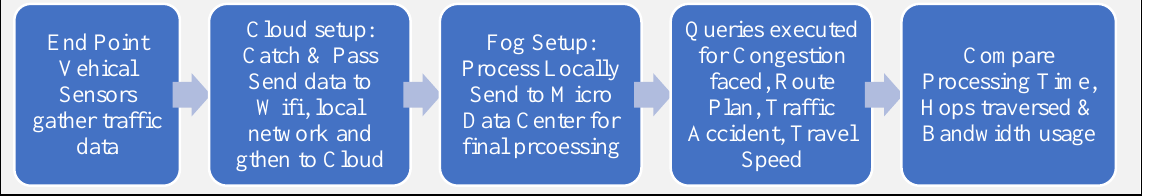
Figure 4. Fog-IoT and Cloud Computing deployment